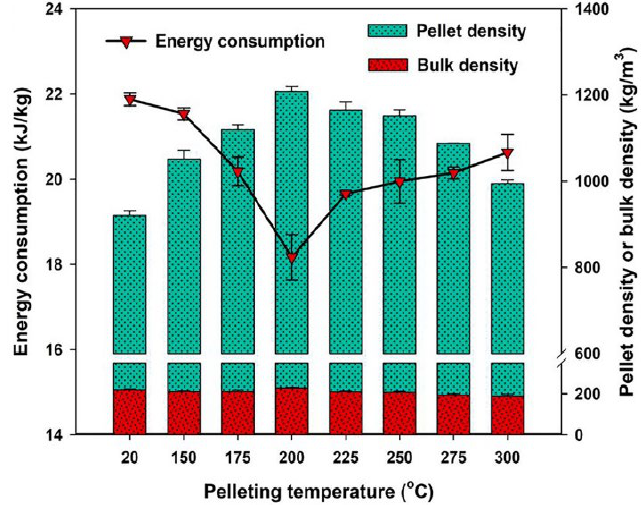
Figure 2. Pellet density and energy consumption for pelletization of untreated and torrefied BPs. Adapted with permission from Ref. [27]. 2022, Elsevier.